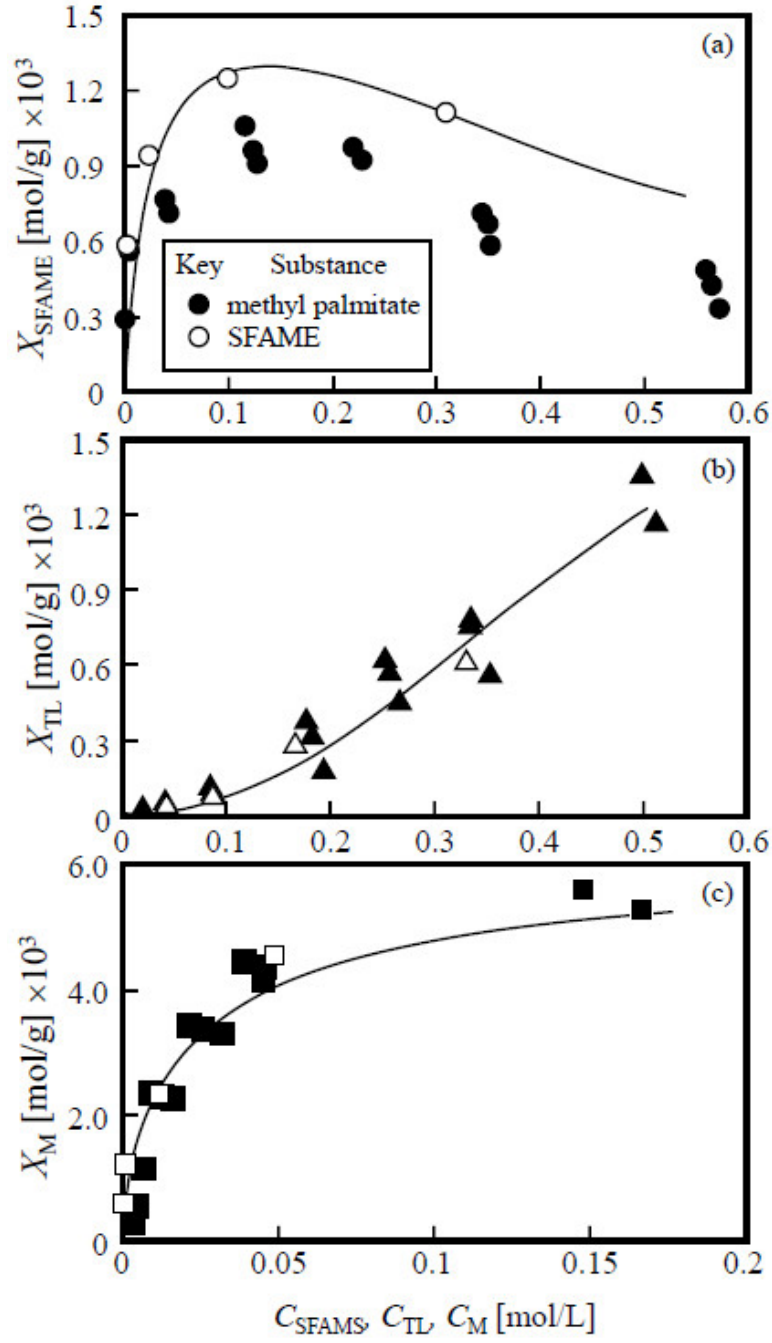
Figure 1. The adsorption isotherms of ( a ) SFAME, ( b ) TL, and ( c ) ME. The solid symbols correspond to the previous data of the methyl palmitate/methanol/toluene system [6]. The solid lines are values calculated using Equations (2)–(4) and the parameters in Table 2.